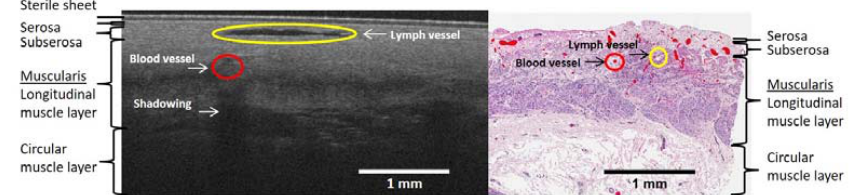
Figure 5. 3D OCT scan of the gastric tube, ( a ) volumetric representation ( b ) with cross section visualized.